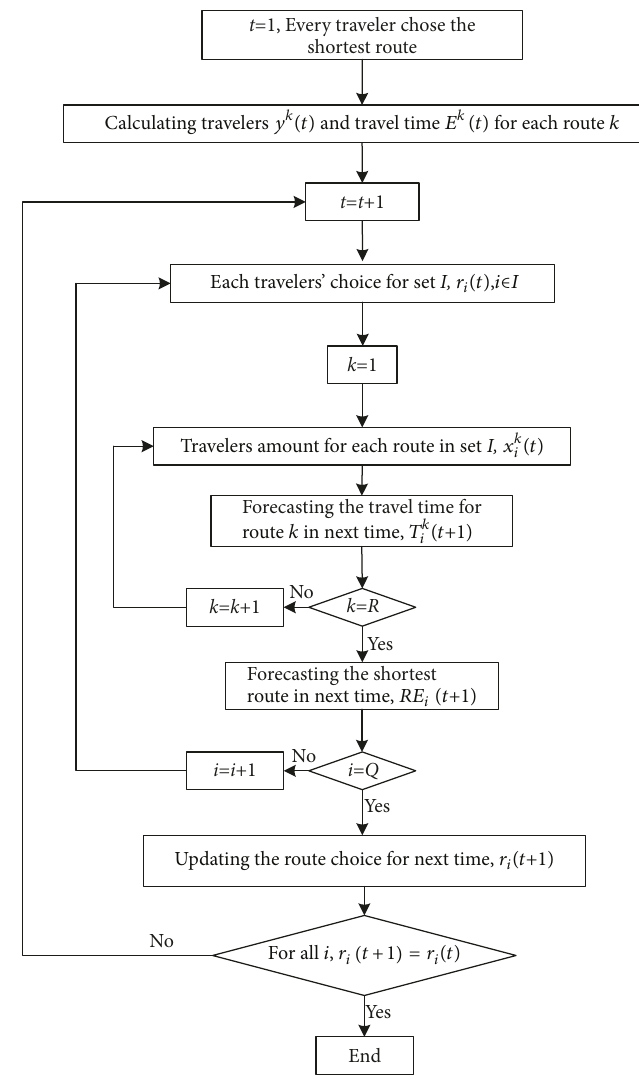
Figure 1: Decision process for